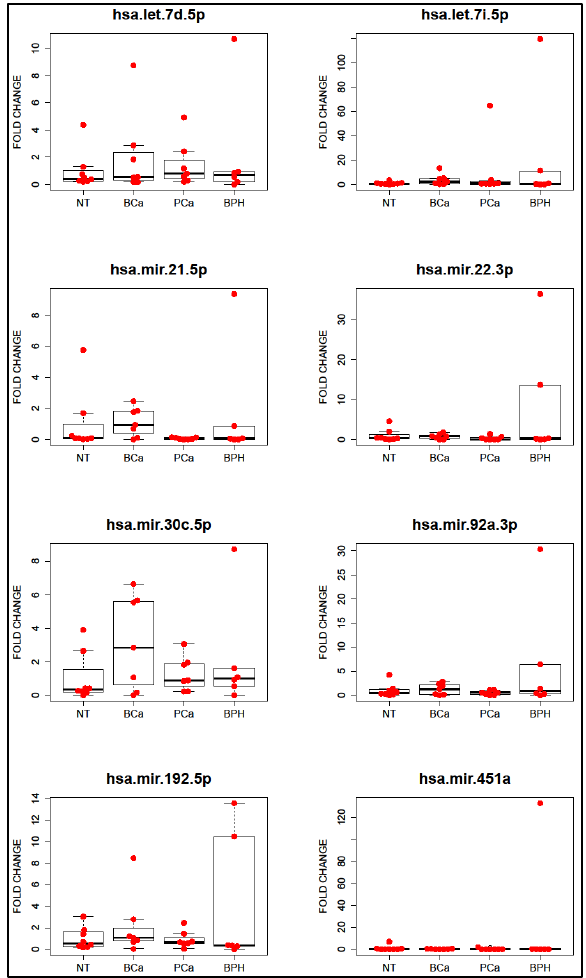
Figure 6. miRNAs analysis of extracellular vesicles (uEVs)-enriched preparations obtained of different genitourinary track pathologies. NT (non-tumoral, patients without malignancies), BCa (bladder cancer), PCa (prostate cancer), and BPH (benign prostate hyperplasia). Fold changes were calculated using cel-mir-39c-3p as housekeeping, and the data was normalized against the average of the NT group, so the average of the group is 1 for each miRNA. ANOVA did not find any significant differences amongst groups.